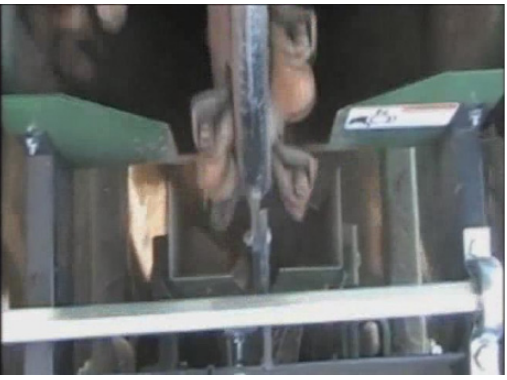
Figure 13. Pickup-finger type metering device. Reprinted with permission from ref. [48] Copyright 2016 Lockwood Industries.